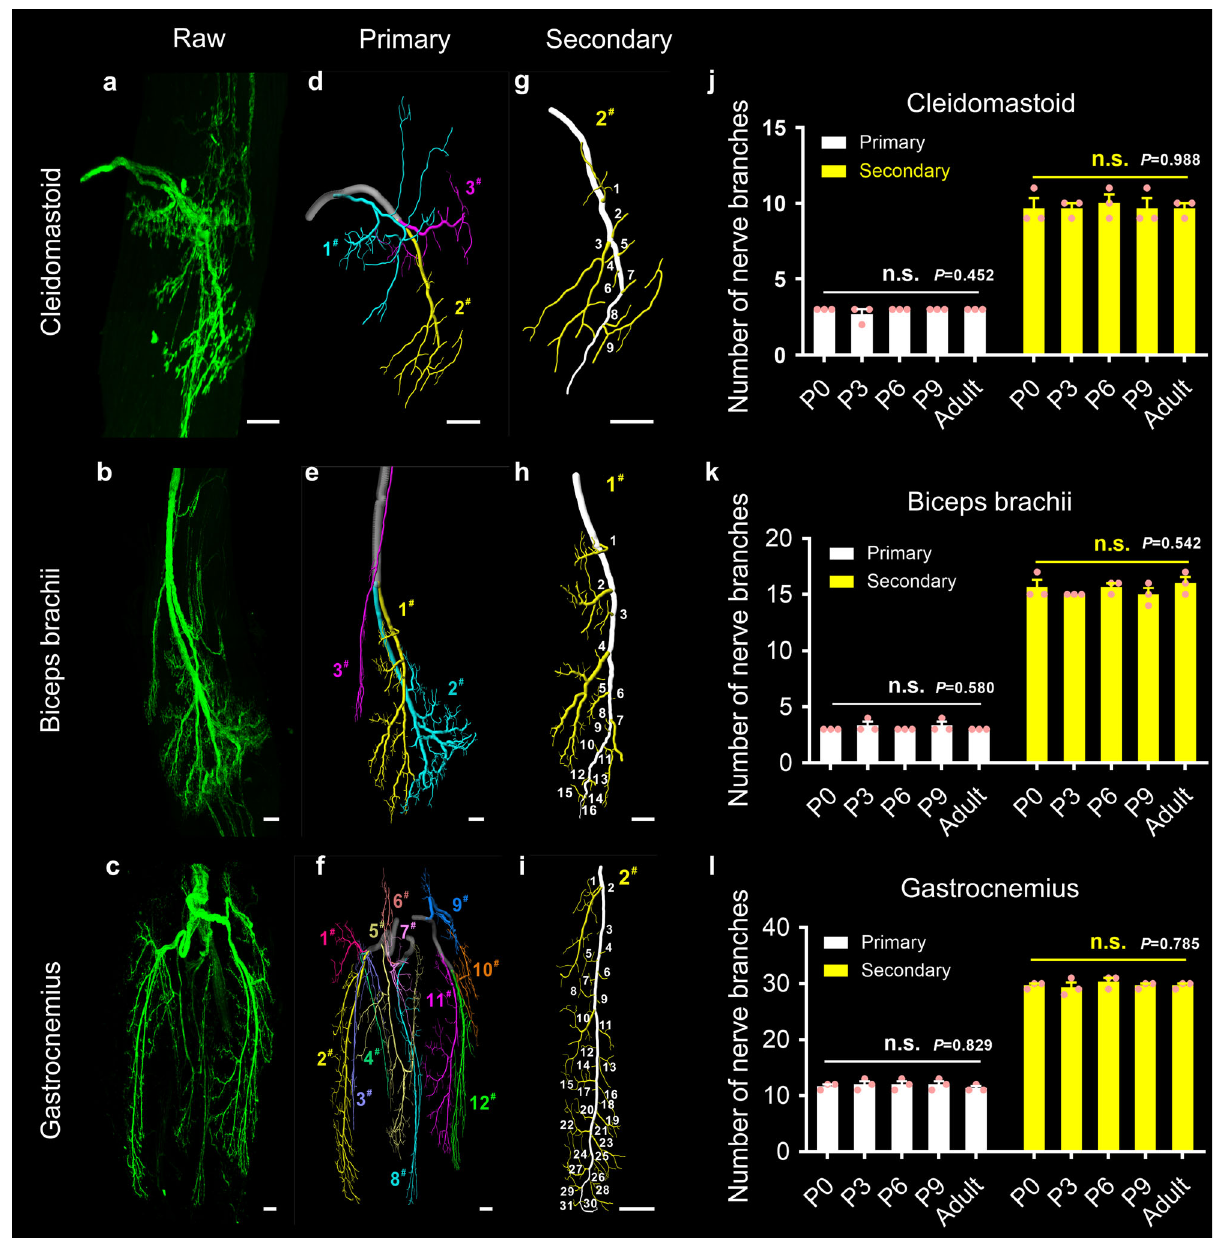
Fig. 5 3D analysis of the intramuscular innervation pattern during postnatal development. a – c The spatial conformation of intramuscular motor nerves in a P0 cleidomastoid ( a ), P6 biceps brachii ( b ), and P3 gastrocnemius ( c ). d – f The segmentation of the nerve branches in a – c by 3D tracing using the Imaris software. The primary branches were noted as originating from the nerve branches entering the muscles and extending from proximal to distal, and they were numbered and marked with different colors. g – i The distribution of secondary branches in the 2 # primary branch of the cleidomastoid ( g ), 1 # primary branch of the biceps brachii ( h ), and 2 # primary branch of the gastrocnemius ( i ). j – l The quanti fi cation of the primary and secondary branches in the cleidomastoid ( j ), biceps brachii ( k ), and gastrocnemius ( l ) during postnatal development and adulthood ( n = 3 independent animals for each muscle at each time point). Scale bar: 100 μ m. All values are presented as the means ± SEM; statistical signi fi cance in j – l (n.s. represents not signi fi cant) was assessed using one-way